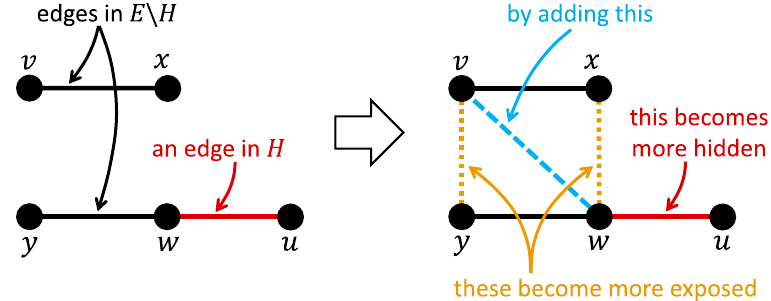
Figure 2. An illustration of the main idea behind the OTC heuristic. Here, the addition of ( v , w ) creates two open triads: one contains the nodes x , v , w ; the other contains v , w , y . In such situations, the similarity scores of ( x , w ) and ( y , v ) increase while that of ( w , u ) could also decrease; see the analysis in Materials and Methods